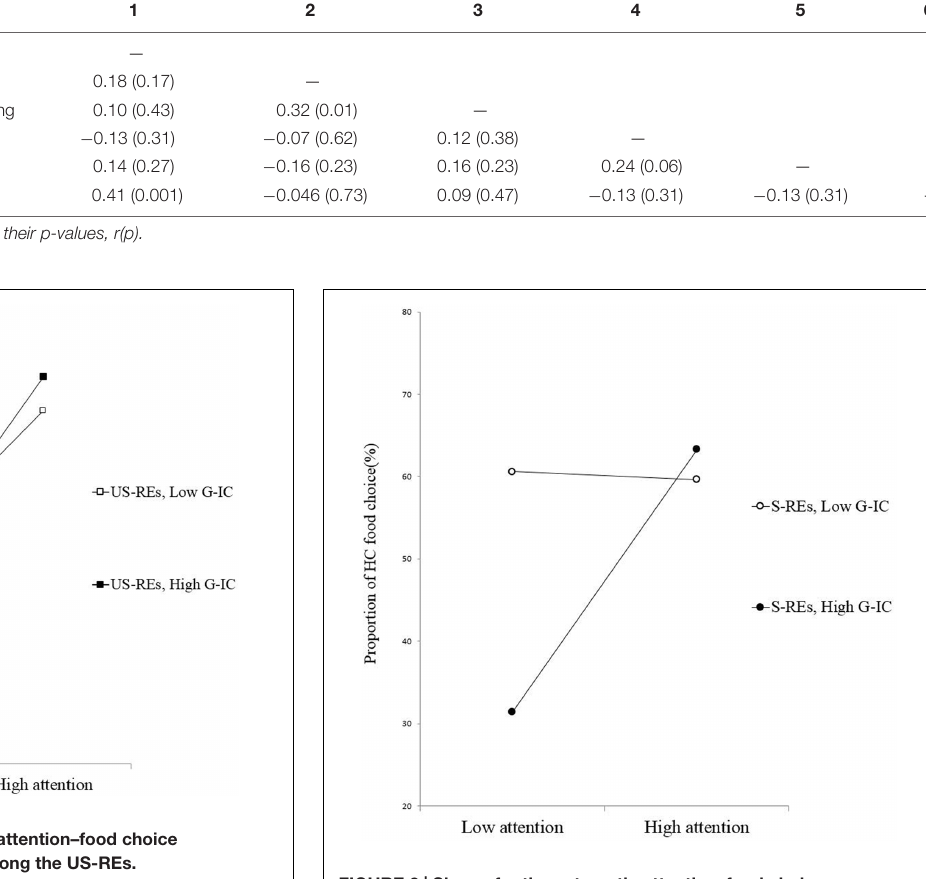
found that this relationship was moderated by G-IC and